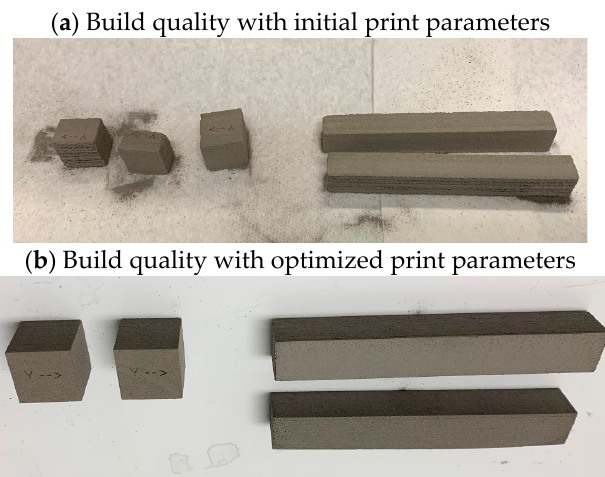
Figure 4. Results from print parameter optimization showing green parts with ( a ) build quality from initial parameter set, and ( b ) build quality from optimized parameter set.